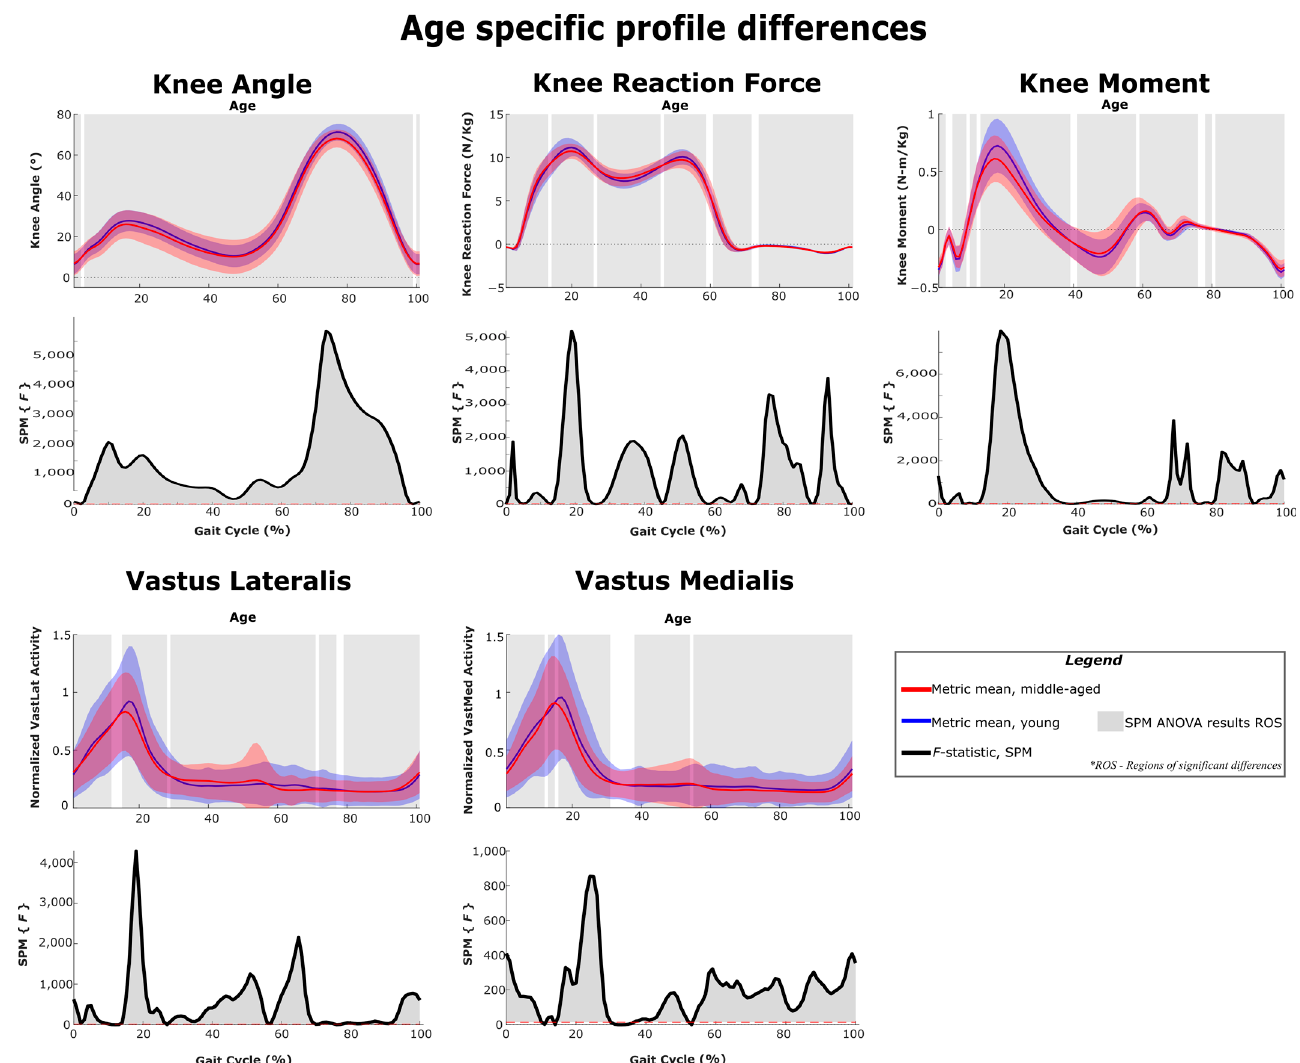
Figure 12. SPM ANOVA results and age-specific differences between the younger and middle-aged cohorts. Joint parameters are primarily related to the knee joint. The F -statistic is qualitatively identical to the effect size and can be used as an indicator of practical significance.